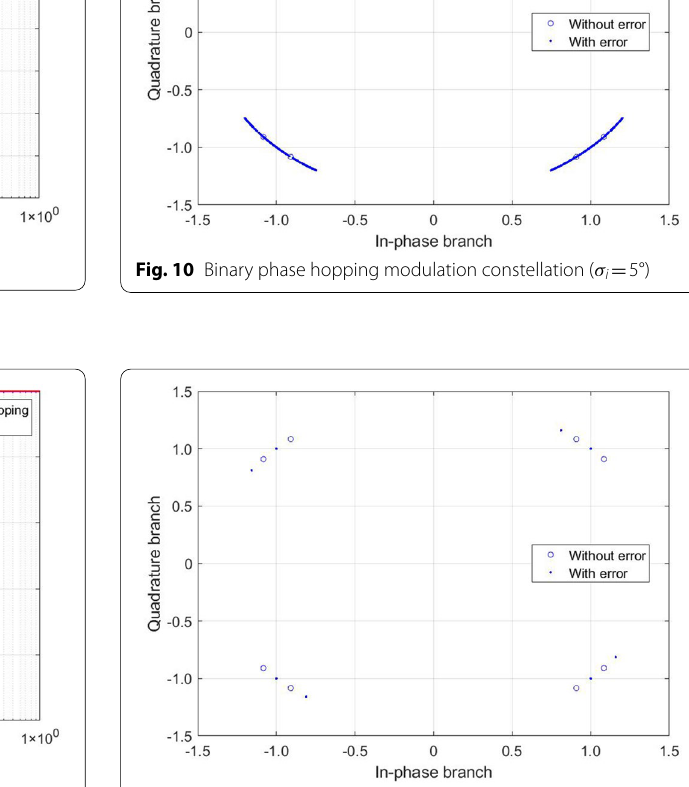
Fig. 11 Binary phase-hopping modulation constellation ( θ e